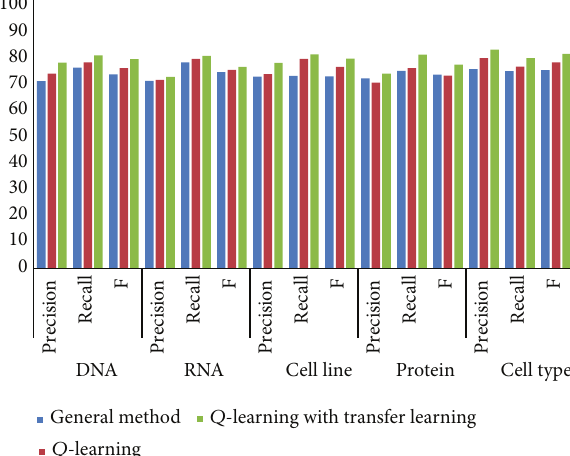
Figure 3: Precision, recall rate, and 𝐹 score results of identifying four kinds of unregistered words: DNA, RNA, cell line, protein, and cell type from GENIA.